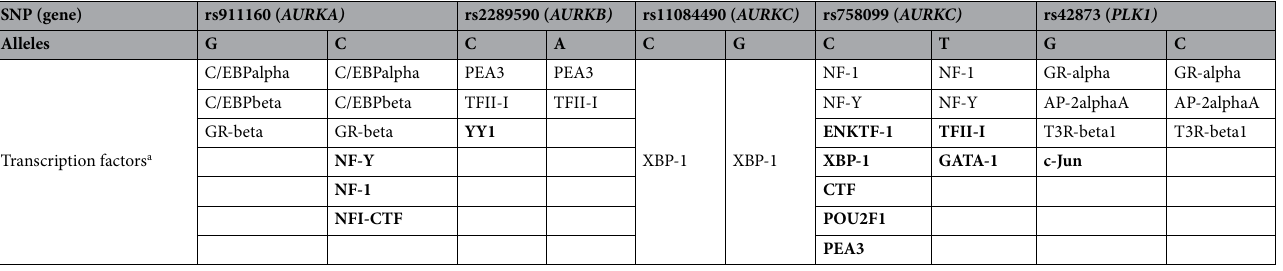
Table 5. Bioinformatic analysis of the studied genetic variants. SNP single nucleotide polymorphism. a Transcription factors binding sites were evaluated using PROMO (ALLGEN) software. Different transcription factor binding motifs identified for polymorphic alleles of the studied polymorphisms are indicated in bold